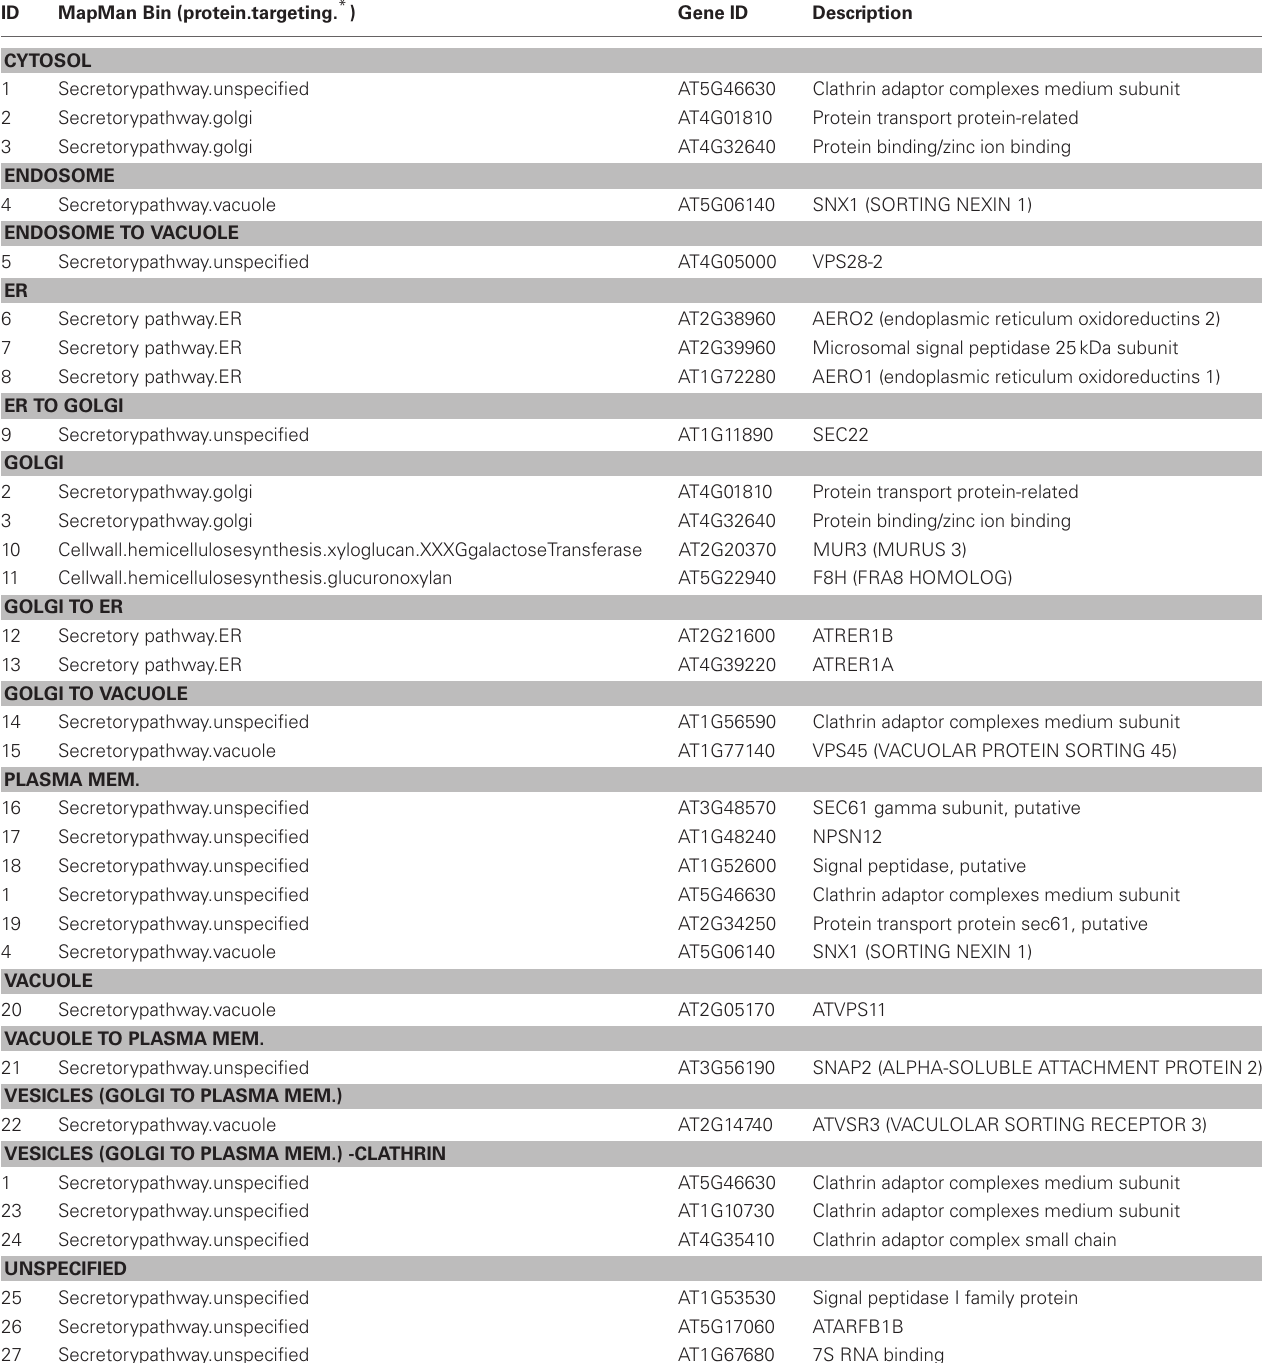
Table 3 | Secretory protein localization.